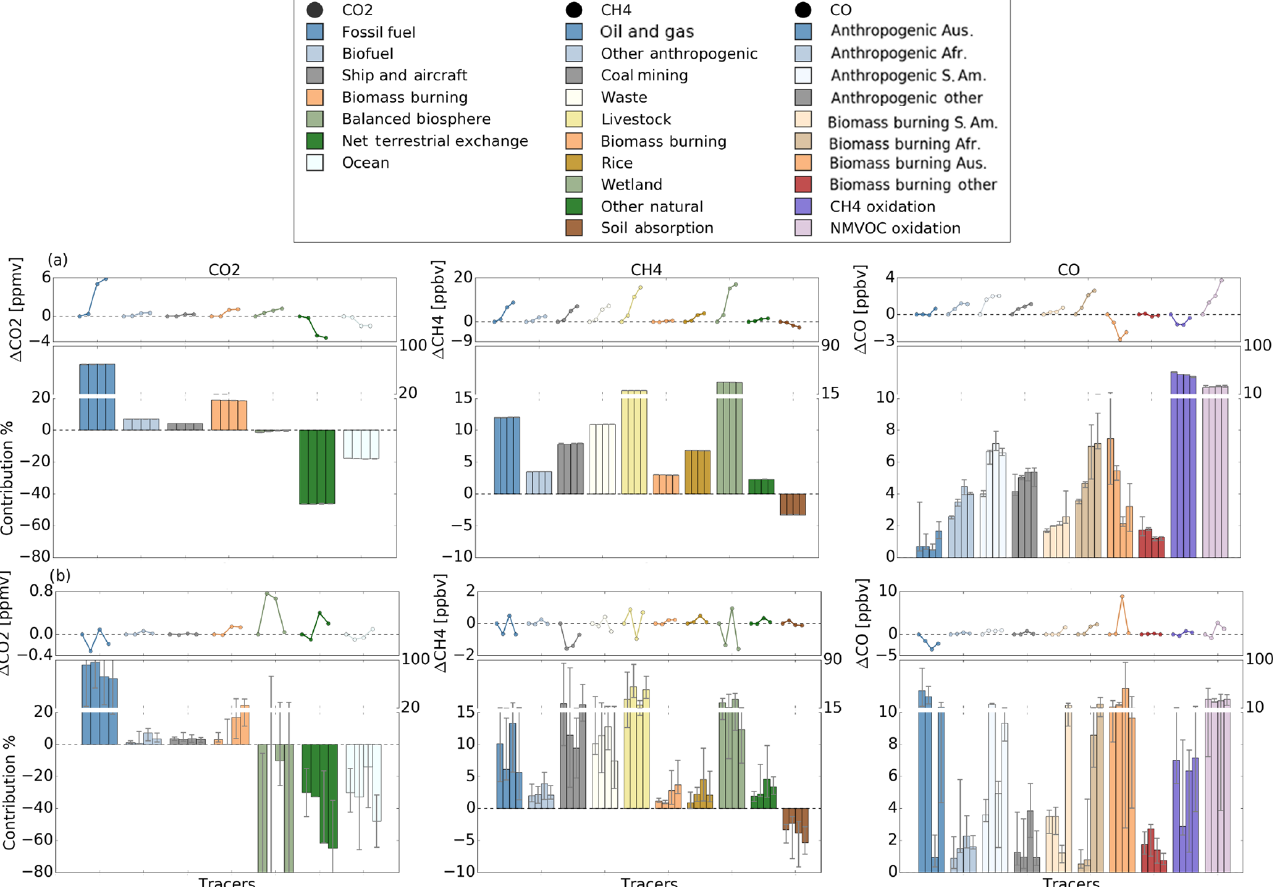
Figure 6. CO 2 , CH 4 and CO tracer contribution across the four measurement section in 2012 and 2013 (2012NB, 20122B, 2013NB and 2013SB; from left to right) for the background (a) and enhancements (b) . We separated out the total amount of each gas into background values and enhancements to examine the impact of different temporal and spatial scales on the change of the sources. The bottom plots show the contribution of each tracer during a specific trip, while top plots show the change of each tracer across the four sections relative to the first section (2012NB). The contributions are calculated based on the median for each section, and the uncertainties represent the 25th (lower error bar) and 75th (upper error bar)